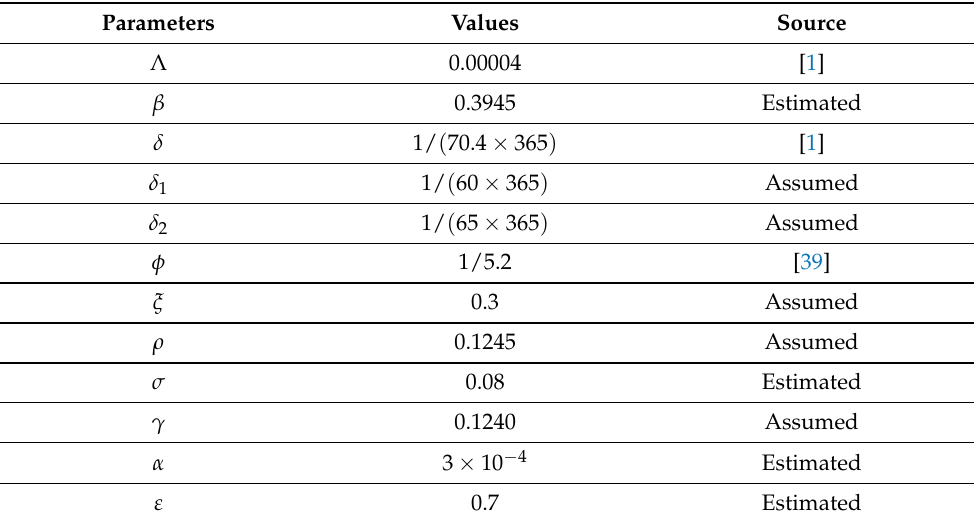
Table 2. The values of the parameters used in system (1) corresponding to the situation in West Bengal (India). Parameters Values Source Λ 0.00004 [1] β 0.3945